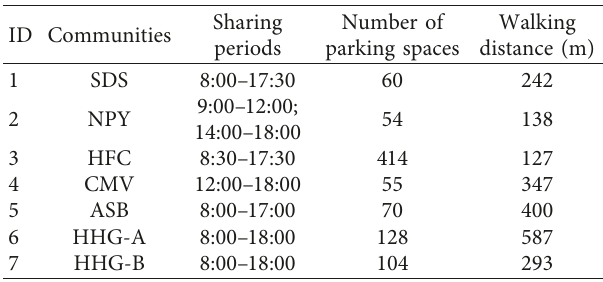
Table 5: Sharing periods of shared parking lots.